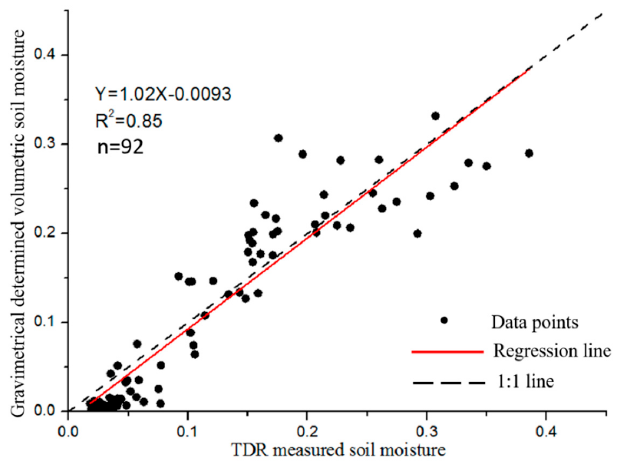
Figure 4. Comparison of TDR-measured SM against gravimetrically determined volumetric SM.